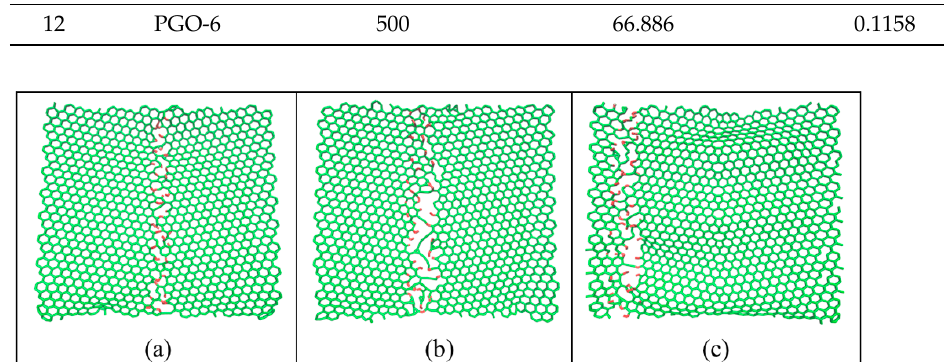
Figure 14. Tensile fracture states of three functional group distribution models. ( a ) fracture state of PGO-1; ( b ) fracture state of PGO-2; ( c ) fracture state of PGO-3.